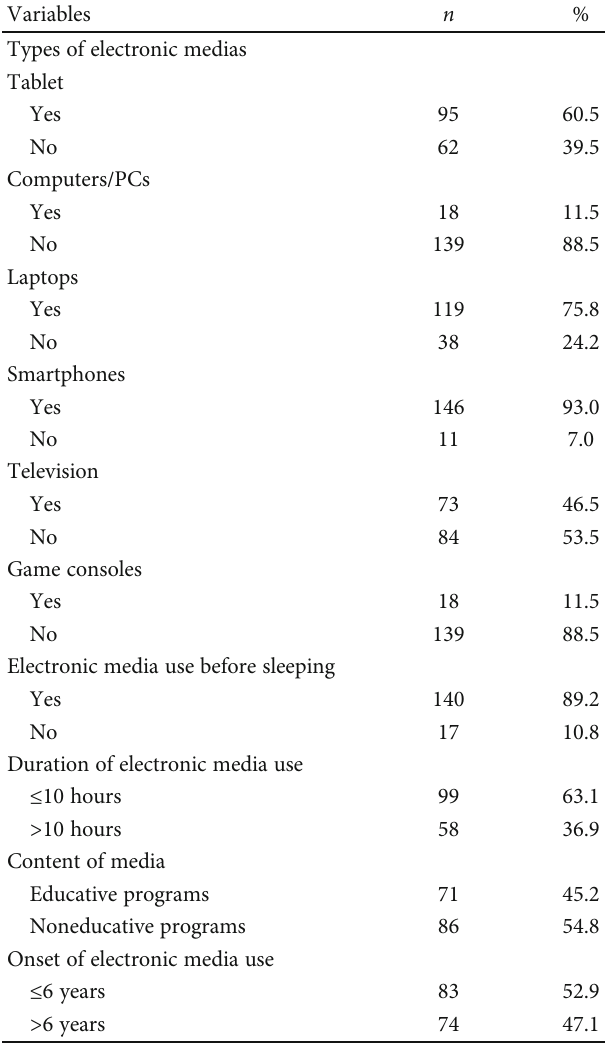
Table 2: Electronic media use ( n = 157 ).